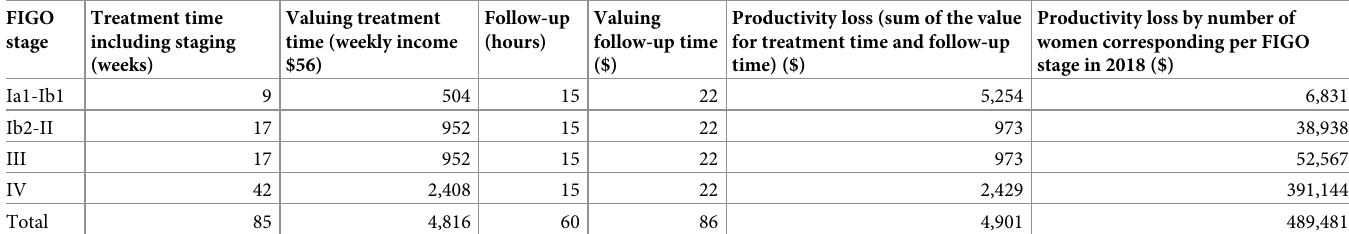
Table 7. Patient time for staging, cancer treatment and follow-up by FIGO stage. FIGO Treatment time stage including staging